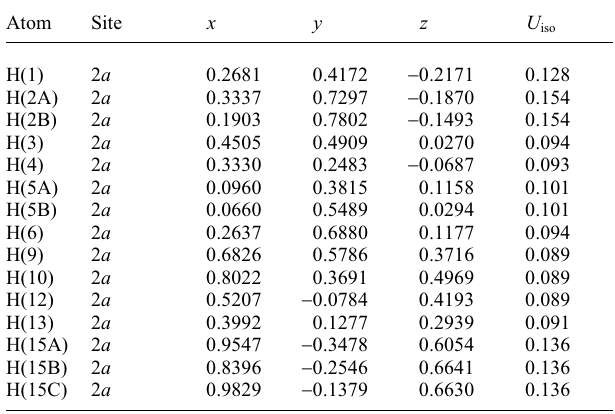
Table 2. Atomic coordinates and displacement parameters (in Å 2 )